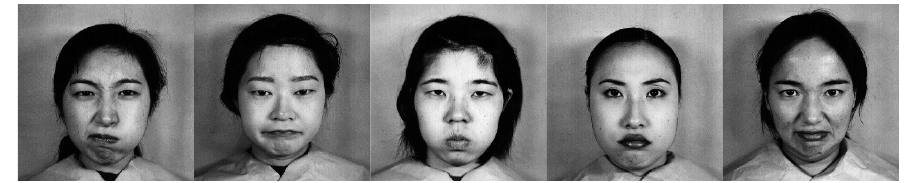
Figure 16. Samples of the Japanese Female Facial Expression